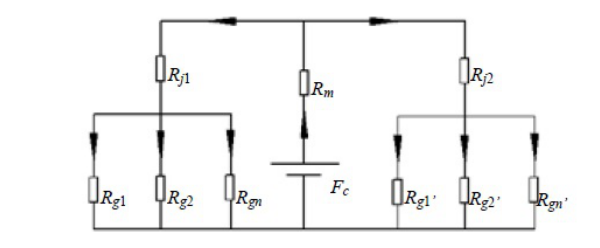
Fig. 4 Equivalent magnetic circuit diagram of split pole shoe before structural optimisation.